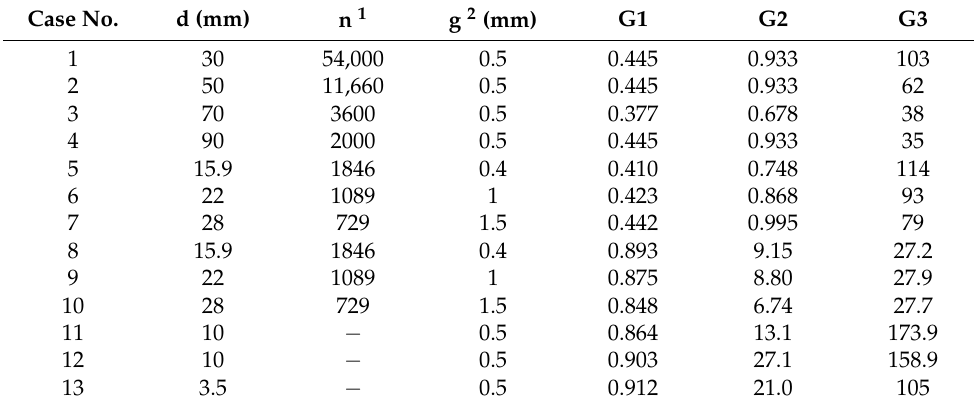
Table 4. Summary of the parameters describing the analysed geometers.